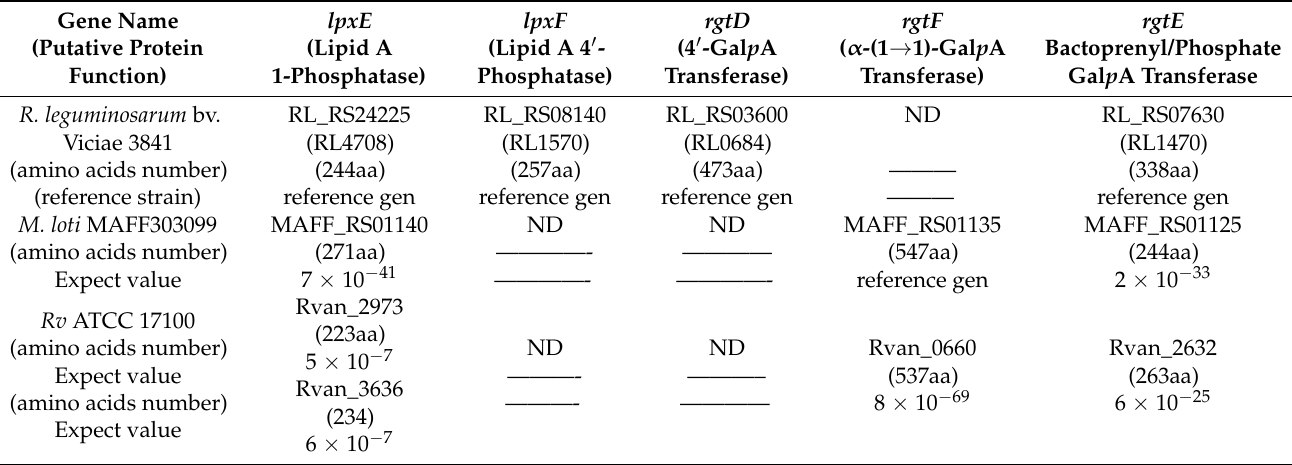
Table 2. Comparison of genes that are possibly involved in modification of Rv ATCC 17100 lipid A with bacterial genes of known functions (reference strains: R. leguminosarum bv. Viciae 3841 and M. loti